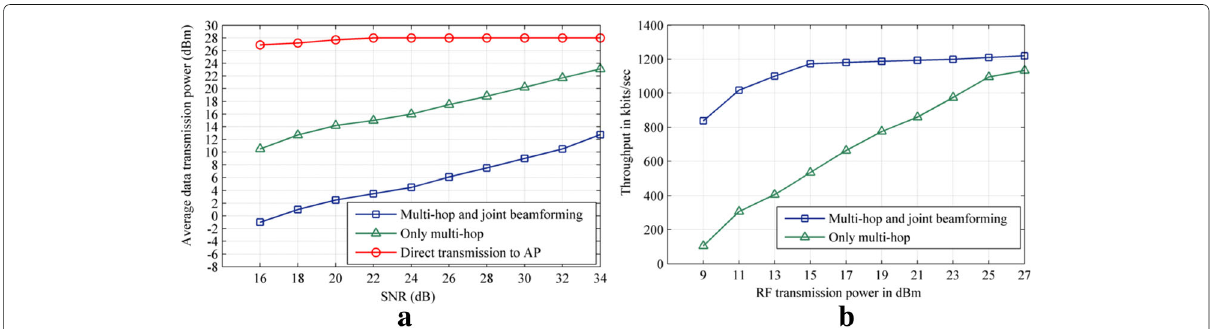
Fig. 14 Power and throughput requirements for different transmission methods. a RF power comparison. b Throughput comparison